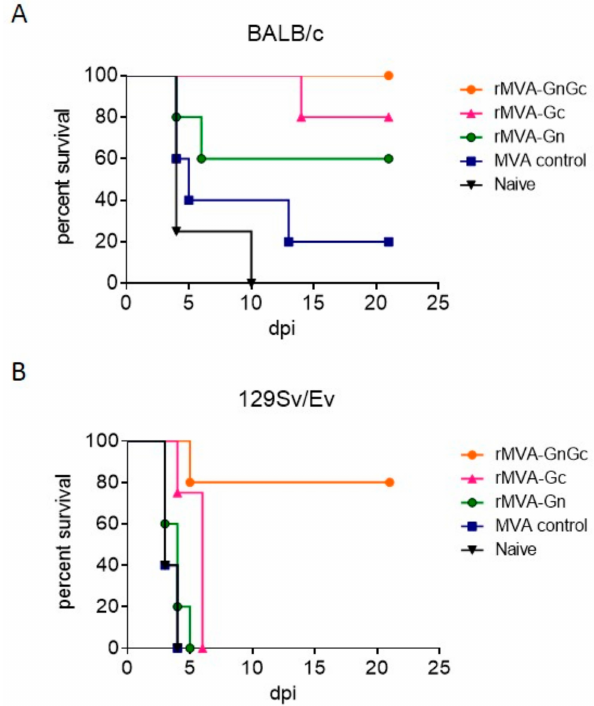
Figure 2. Survival of MVA vaccinated mice ( n = 5) upon challenge with virulent Rift Valley fever virus (RVFV). Kaplan–Meier plots of BALB / c mice (haplotype H2 d ( A ) or 129EvSv mice (haplotype H2 b ) ( B ). The mice were vaccinated with a single intraperitoneal dose of 10 7 pfu of each recombinant virus or were mock-vaccinated (naive). Two weeks after immunization the mice were challenged with 10 3 pfu of RVFV 56 / 74. The mice were monitored for 3 weeks for the presence of signs of